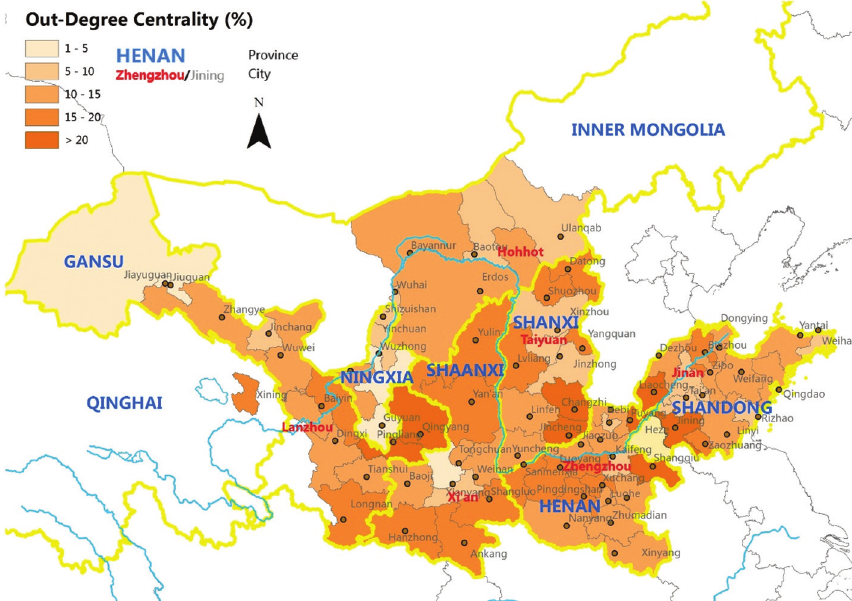
Figure 5: Distribution map of out-degree centrality of cities in the Yellow River